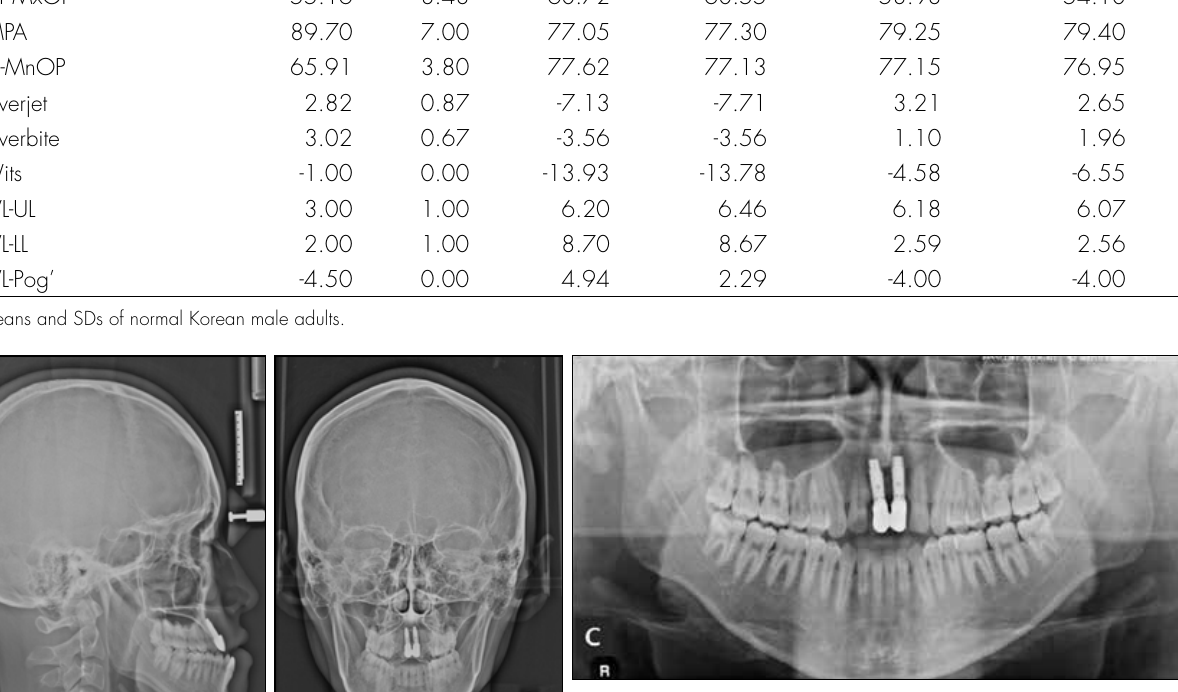
adjusted edgewise brackets with 0.022-inch slots were placed in both arches, and bands with rectangular tubes cemented on the maxillary first molars. Angulation control of the anterior teeth was required between the lateral incisor and canine to create space for intended vertical osteotomy sections. Modified bracket positioning was accommodated and used